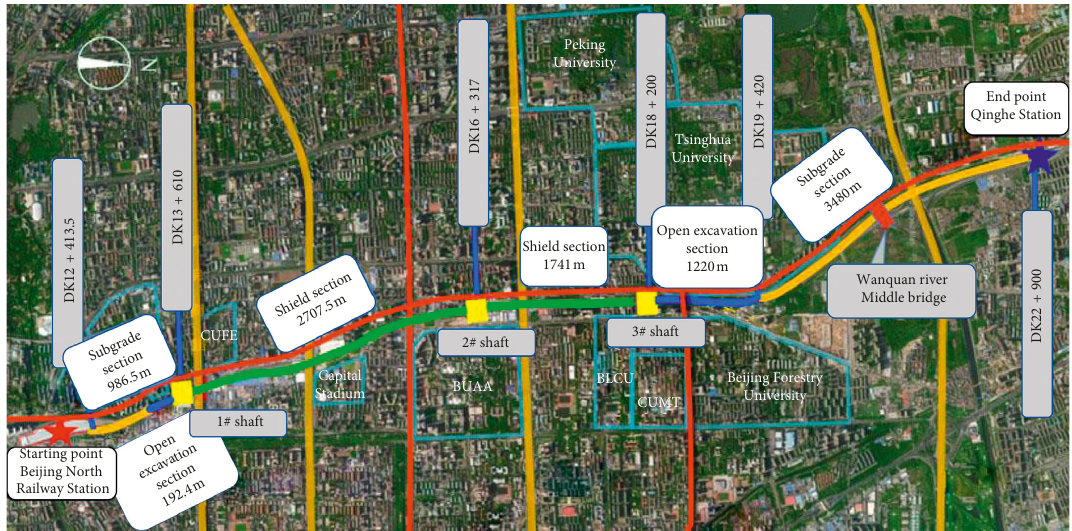
Figure 1: Overview of the Tsinghuayuan Tunnel project.